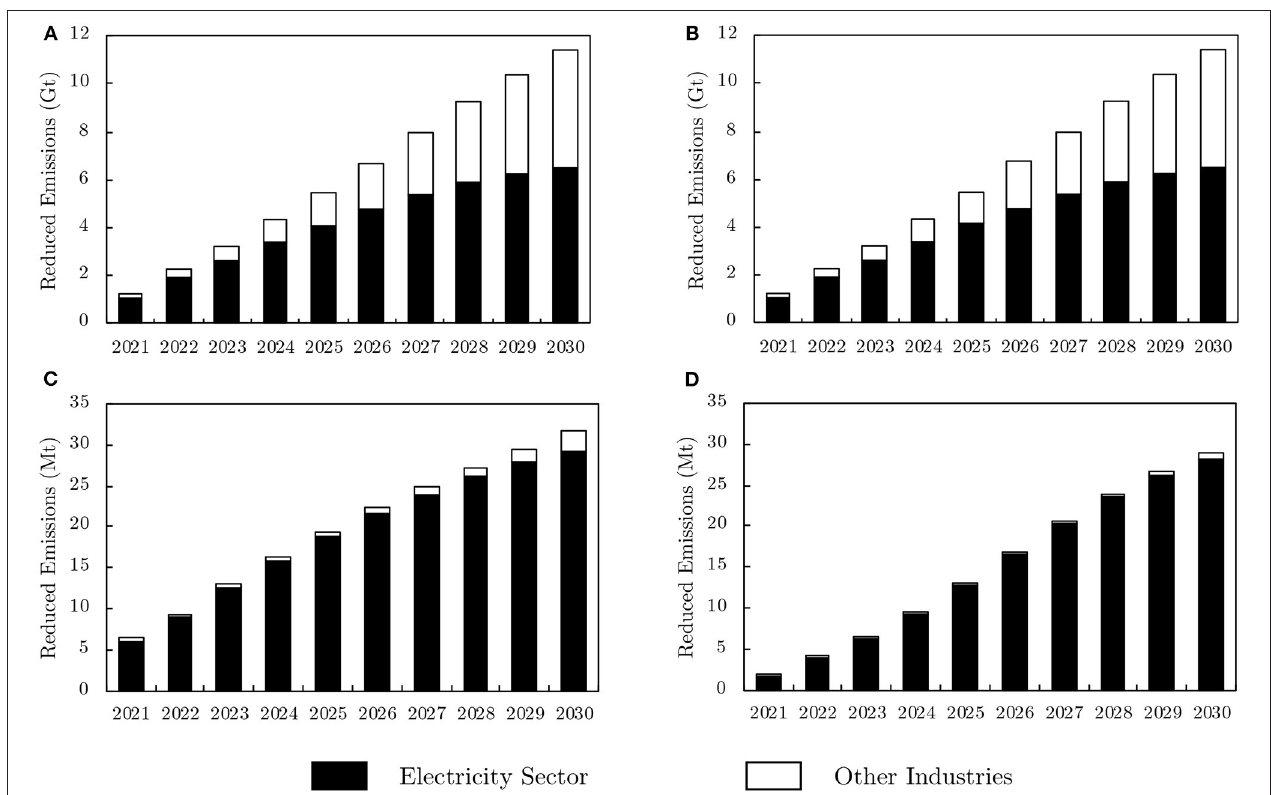
FIGURE 5 | Carbon mitigation under stringent mitigation scenarios (vs. BAU Levels): (A) China, IPCC ; (B) China, IPCC_INT ; (C) Hong Kong, IPCC ; (D) Hong Kong, IPCC_INT